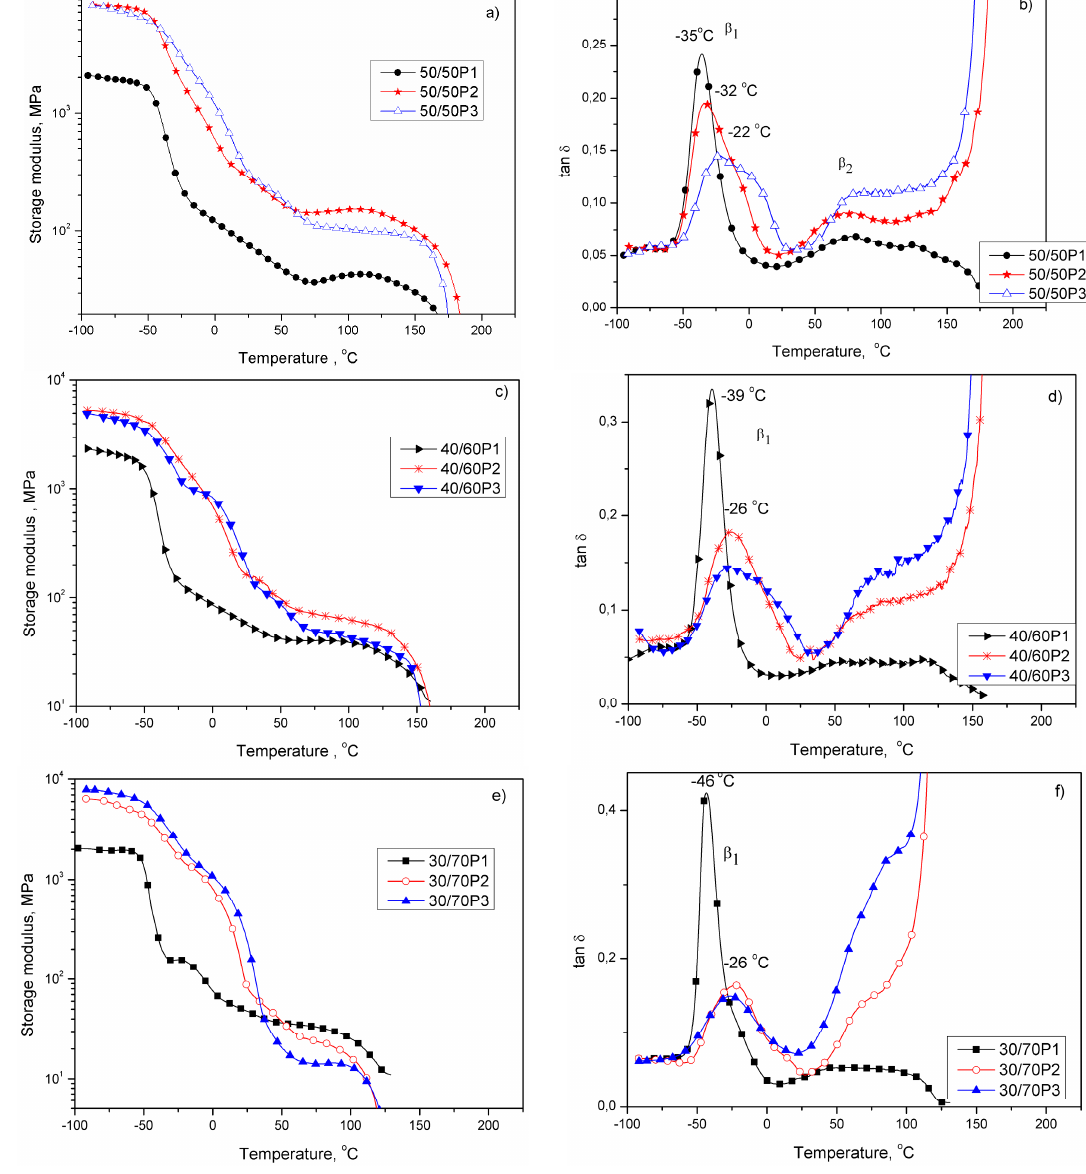
Figure 3. The storage modulus ( a , c , e ) and tan δ ( b , d , f ) as a function of temperature for PTT- b -PEOT copolymers with PEOT content of 50 ( a , b ), 60 ( c , d ) and 70 ( e , f ) wt %.